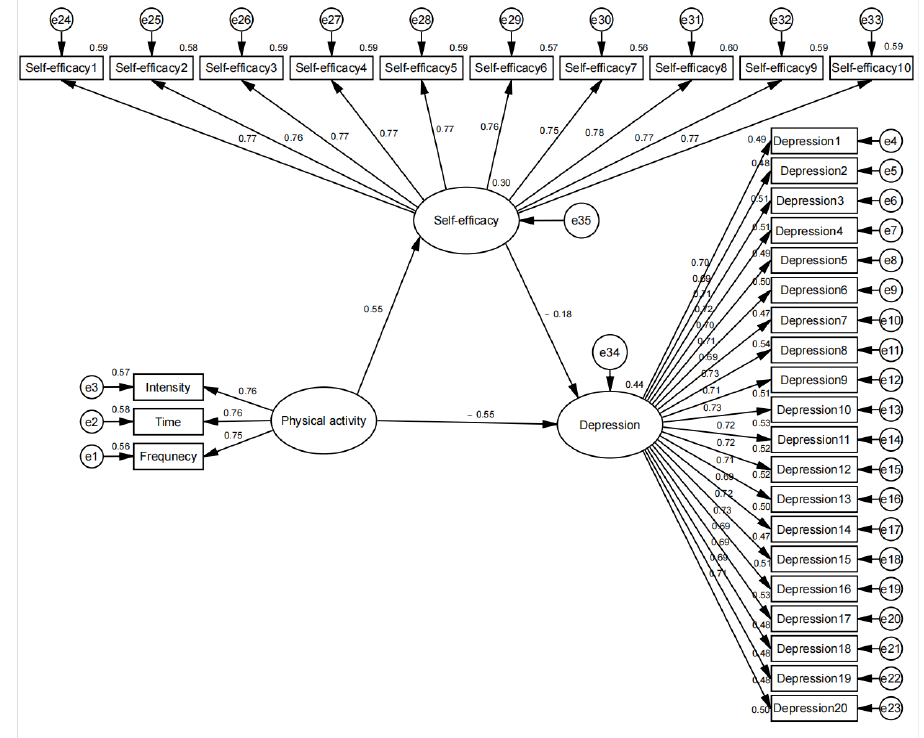
Figure 4. A structural equation model on the role of self-efficacy in mediating between physical activity and mental depression.